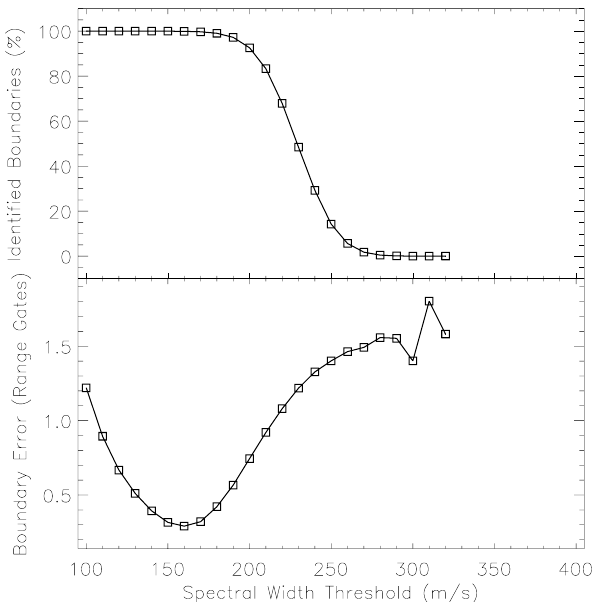
Fig. 10. The distribution of spectral width values below and above the spectral width boundary as determined by applying algorithm 3 to the simulated data set. The four different lines represent the re- sults from using four different spectral width threshold values (150, 200, 250, and 300 m/s) to identify the